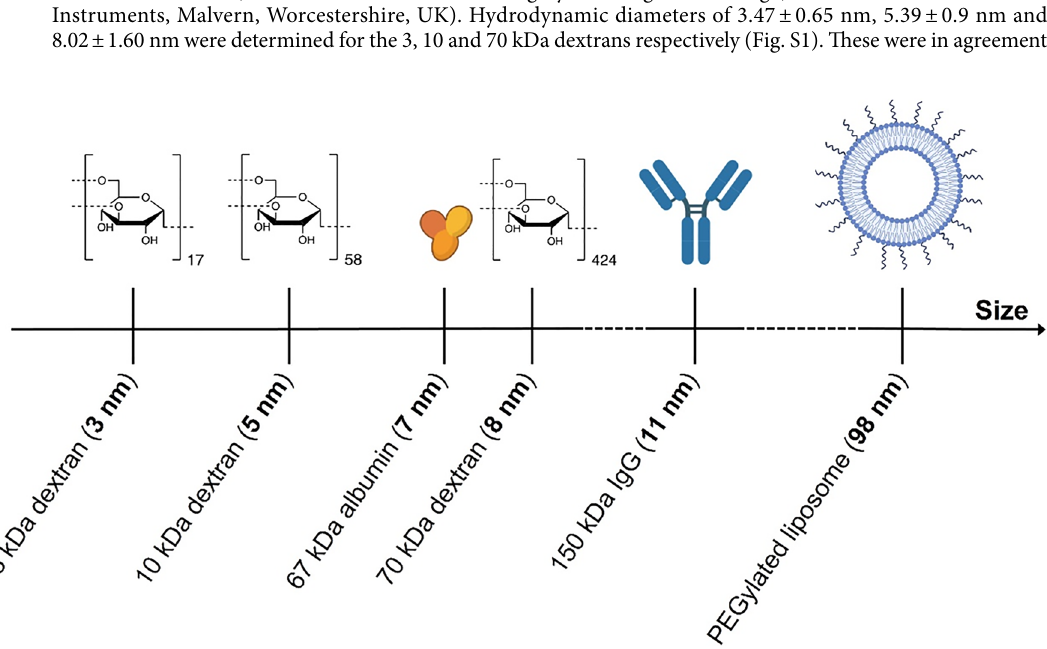
Figure 2. Model agents administered and endogenous proteins assessed for extravasation. Lysine-fixable Texas Red-labeled 3 kDa dextran (hydrodynamic diameter: 3.47 ± 0.65 nm), 10 kDa dextran (hydrodynamic diameter: 5.39 ± 0.9 nm), 70 kDa dextran (hydrodynamic diameter: 8.02 ± 1.60 nm) or DiD-PEGylated liposomes (hydrodynamic diameter: 97.9 ± 2.2 nm) 48 were administered to mice, immediately prior to their treatment